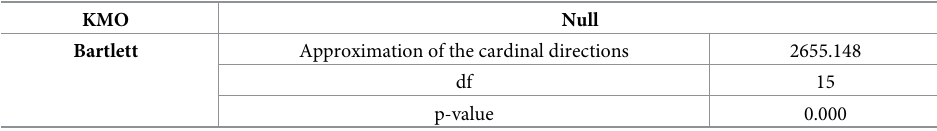
Table 2. Principal component analysis checklist.